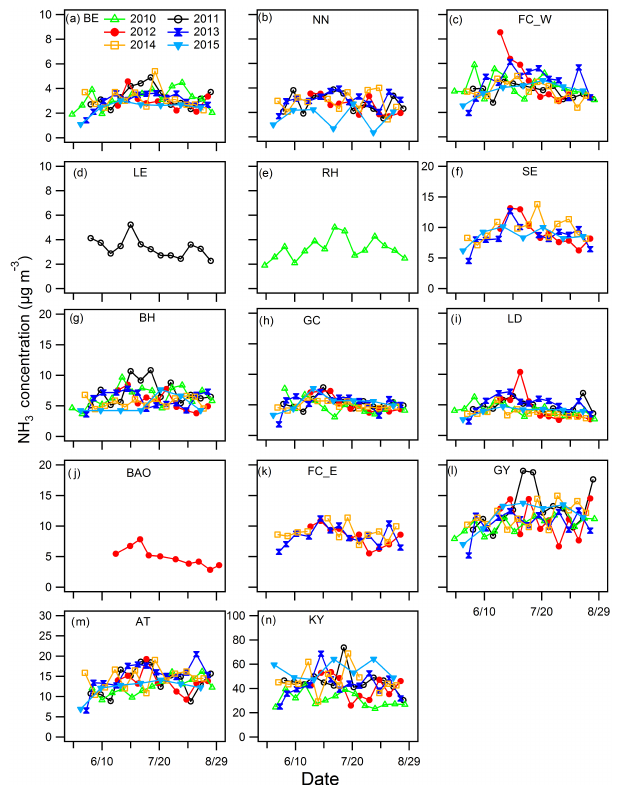
Figure 3. Temporal variations in NH 3 concentrations (unit: µgm − 3 ) at each site from 2010 through 2015. Note the differences in the y -axis